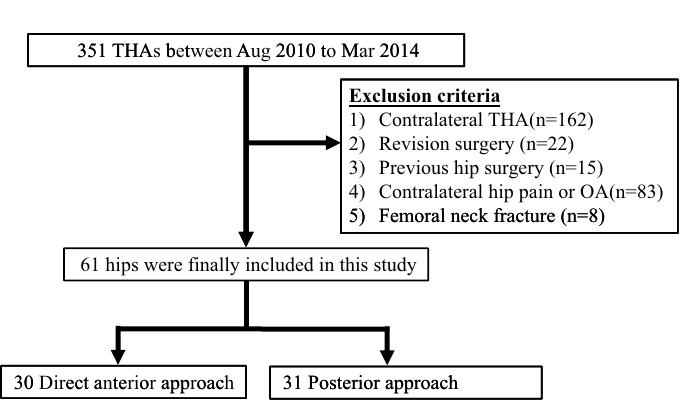
Figure 1. Flow chart of this